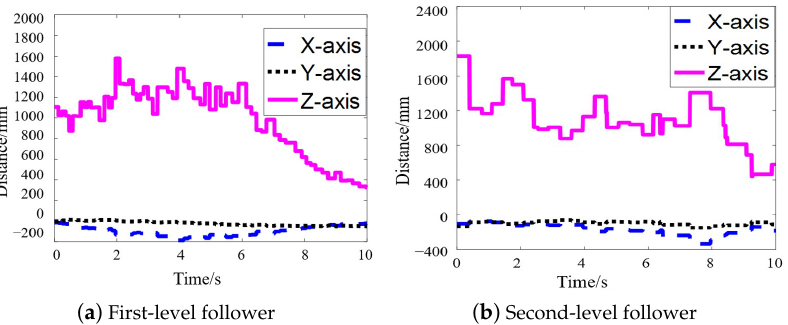
Figure 31. Distance measured by the first-level follower robot and the second-level follower robot over time.